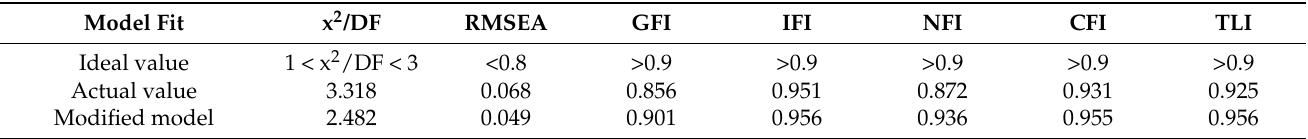
Table 4. Model fitting